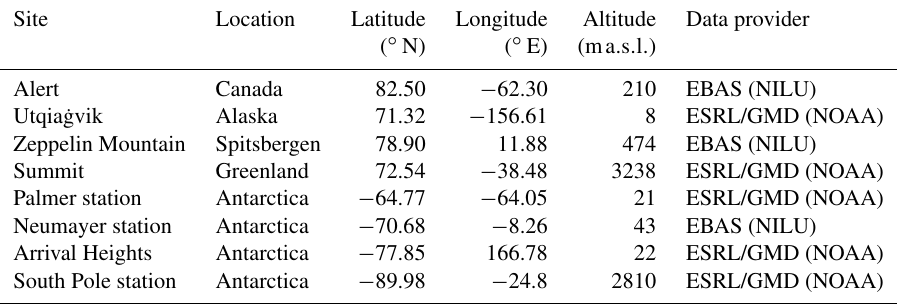
Table 2. Observation sites for surface ozone comparison. However, for Palmer station and Arrival Heights, no observations of surface ozone are available for the year 2000, so we present only model results for these two stations. Site Location Latitude Longitude Altitude Alert Canada 82.50